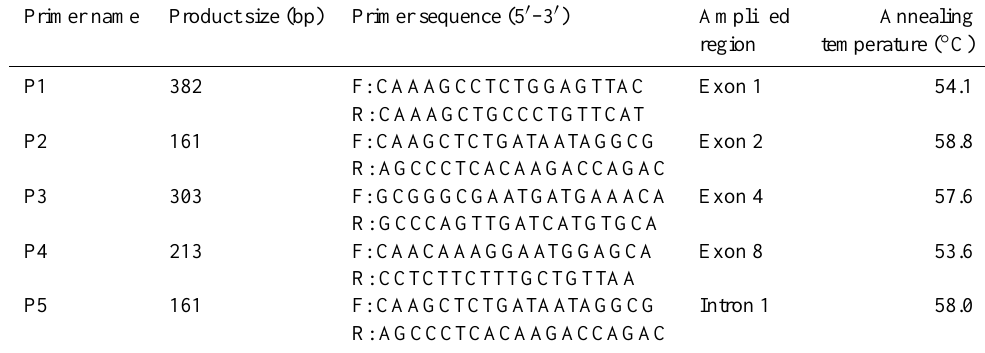
Table 1. Primer sequence, product size and annealing temperature used in analyses of quail ESR